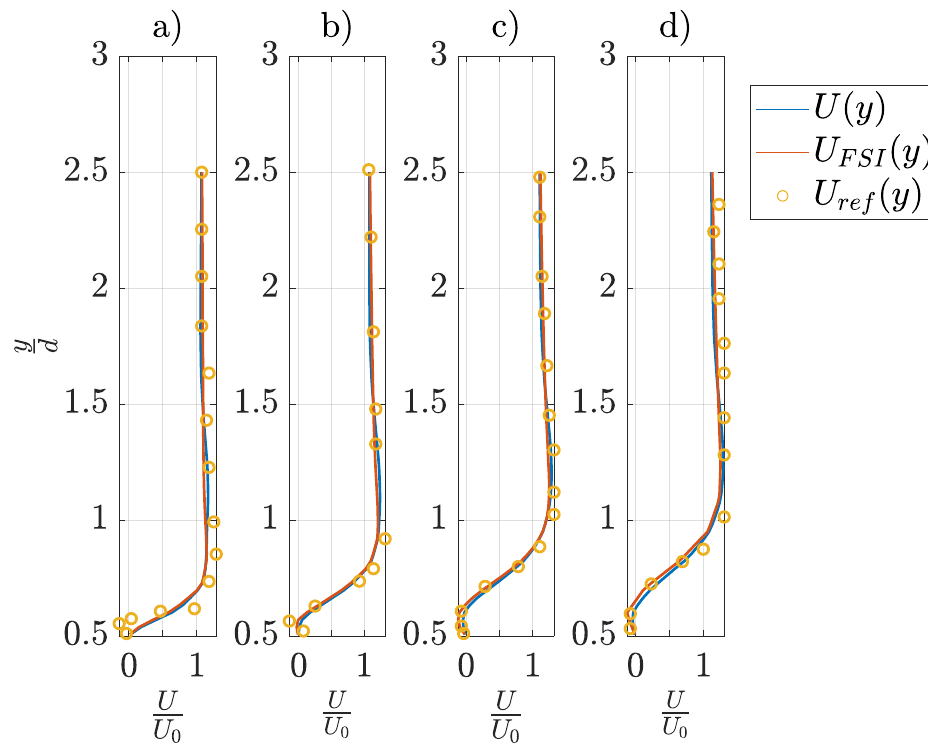
Figure 3. Profiles of the mean streamwise velocity component at different locations: ( a ) x = − 0.375 d , ( b ) x = − 0.125 d , ( c ) x = 0.25 d and ( d ) x = 0.5 d . U ref refers to the results of